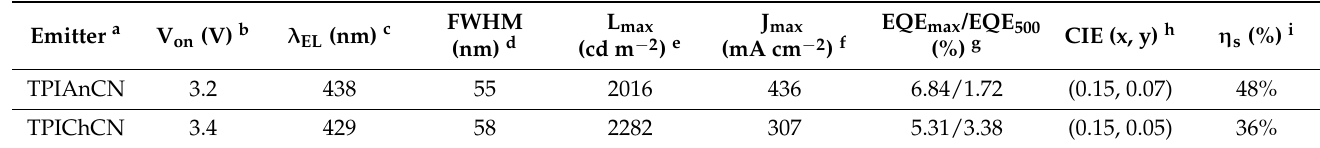
Figure 7. ( a ) Normalized electroluminescence (EL) spectra (insert: photographs of devices operated @ 8 V)), ( b ) Current density-voltage-luminance ( J-V-L ) plots and ( c ) EQE-current efficiency ( EQE-J ) plots of the OLEDs. ( d ) Current density-voltage ( J-V ) plots of the hole-only devices. Table 2. Key performance parameters of the fabricated OLEDs using TPIAnCN and TPIChCN as emitters.